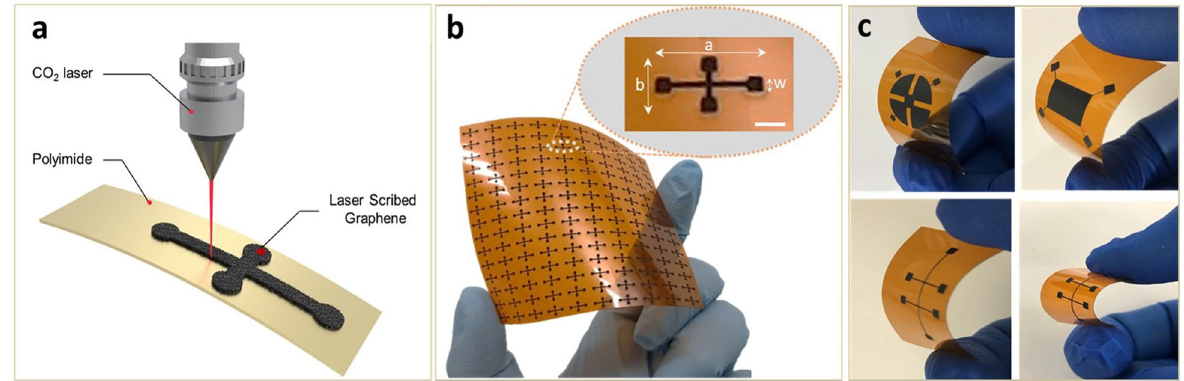
Fig. 9 Fabrication and the geometry of the fl exible Hall sensors based on LSG. a Schematic of the fabrication process of graphene Hall- effect sensors using a CO 2 laser. b Array of printed fl exible LSG Hall-effect sensors. The inset shows a single cross-shaped LSG Hall sensor (scale bar: 2 mm). c Examples of various device architectures and